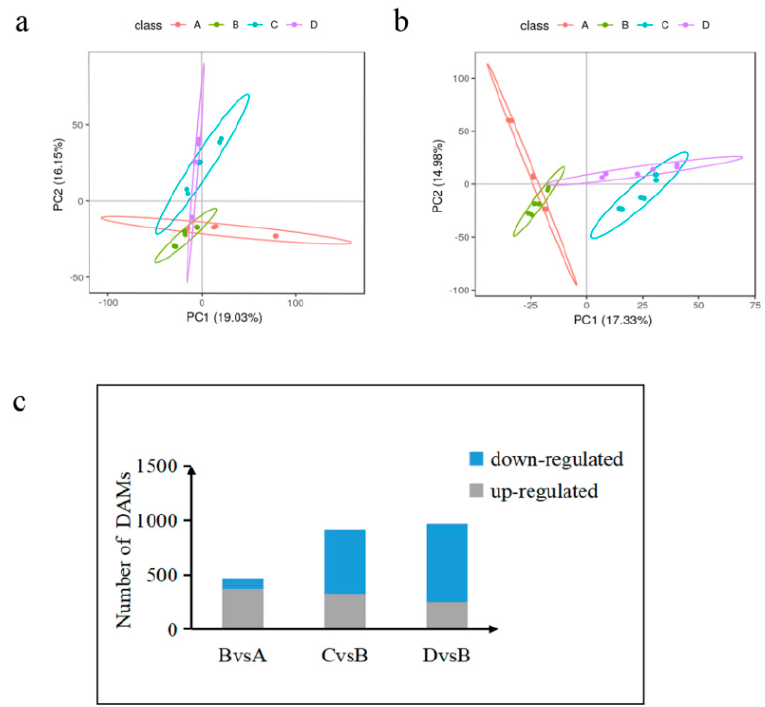
Figure 6. Accumulated metabolite PLS-DA and analysis of DAMs in each comparison group. ( a ) Core diagram of PLS-DA model for each comparison group in the case of positive model. ( b ) Core diagram of the PLS-DA model for each comparison group in the case of negative model. ( c ) Differential number of DAMs in each comparison group. A: control group; B: treadmill group; C: acupoint catgut embedding group 1; D: acupoint catgut embedding group 2. PLS-DA: partial least-squares discriminant analysis; DAMs: differentially accumulated